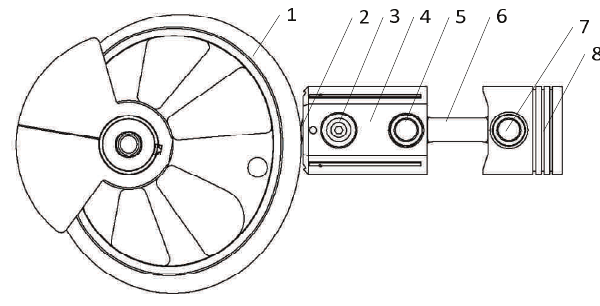
Fig. 2. Cam-piston mechanism (desctiption in the text) In these systems, a drive cam (1) cooperates with the roller-bearing (2) mounted on a pin (3) which is associated Fig. 1. Crank-piston mechanism: 1 – crankshaft, 2 – connecting rod, 3 – piston pin, 4 – piston with the piston rod (4) connected to the piston (8) by means of the connector (6) with has two more pins (5), (7). Histor- ically one of the first uses of the CPM was Daniela's 1906 cam engine [1]. The feature of the CPM is the lack of a clear connection between the cam and the roller